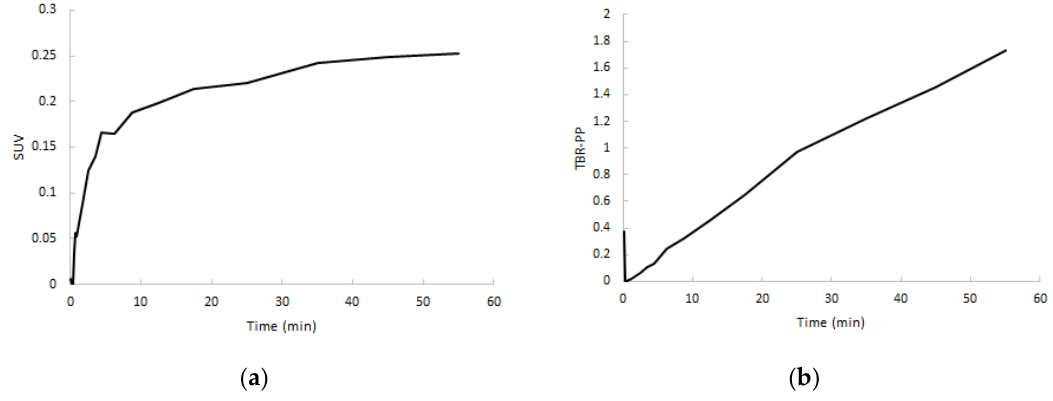
Figure 6. Normalized SUV curves ( a ) and target-to-metabolite corrected plasma ratio (TBR-PP) curves ( b ) of RA-affected joints from the same subject.